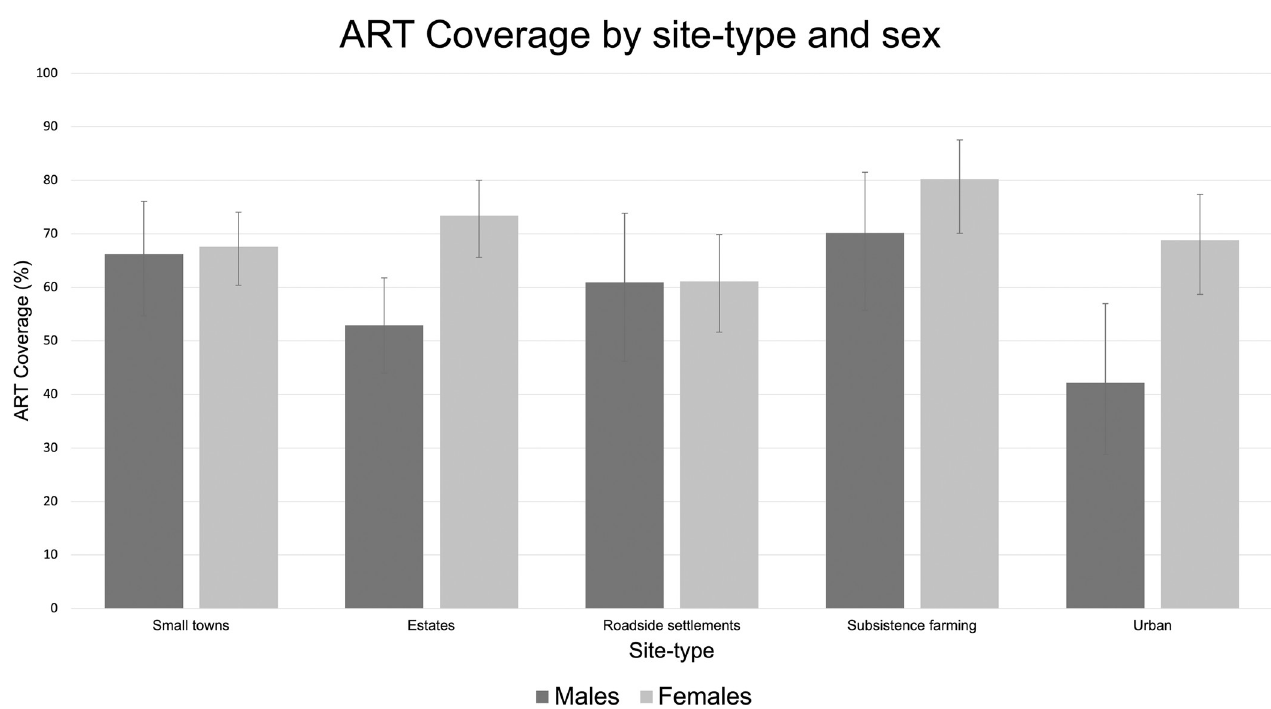
Fig 4. Breakdown of ART coverage by site-type and sex. ART coverage is shown among participants who tested positive in our study, regardless of HIV status awareness or previous diagnosis. Error bars represent 95% CI. Asterisks ( � ) indicate differences that are statistically significant at the level of p < 0.05.